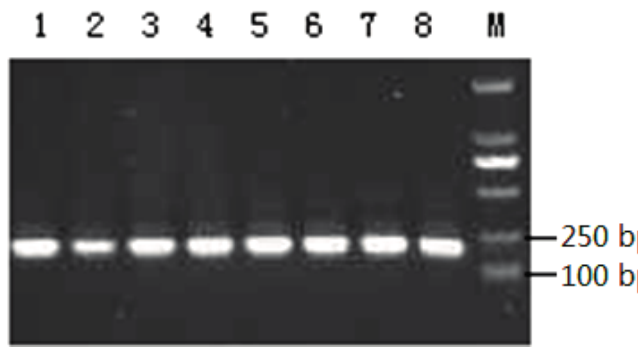
Figure 2. Agarose gel (1%) electrophoresis for BPI gene PCR products. Lanes 1 – 8 : BPI gene products; M : DL2000 molecular weight